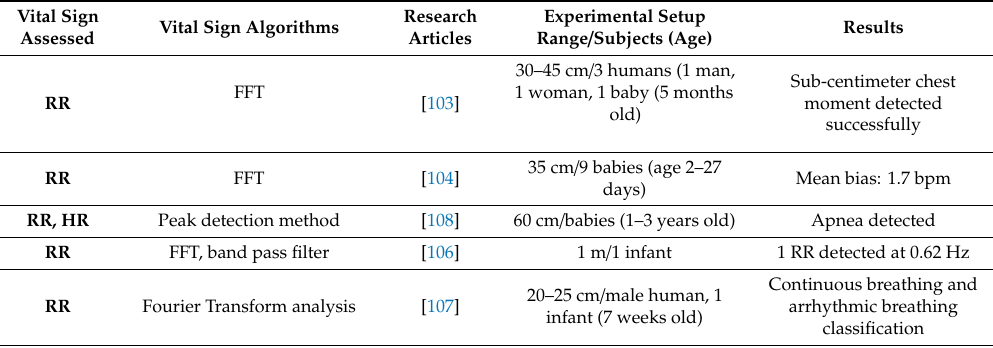
Table 6. Performance comparison of vital sign detection algorithms for neonates